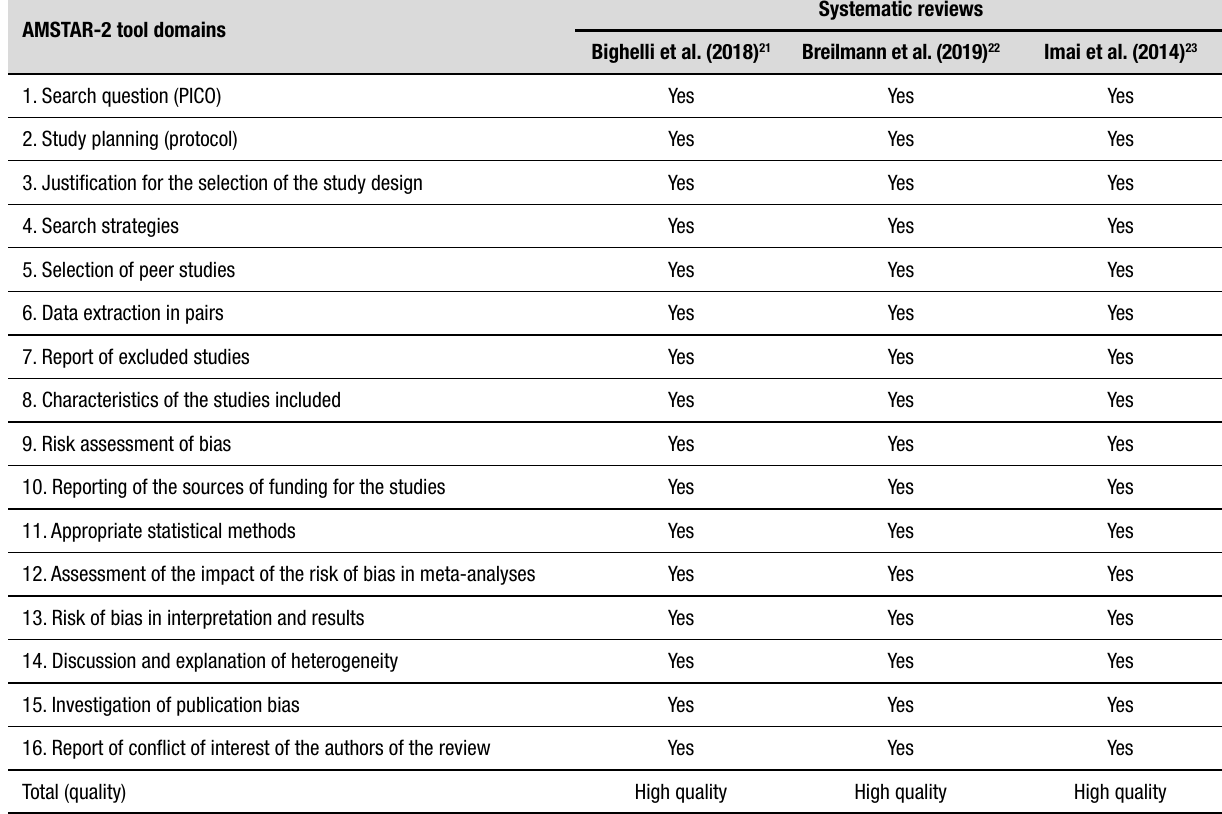
Table 2. Main findings from the included systematic